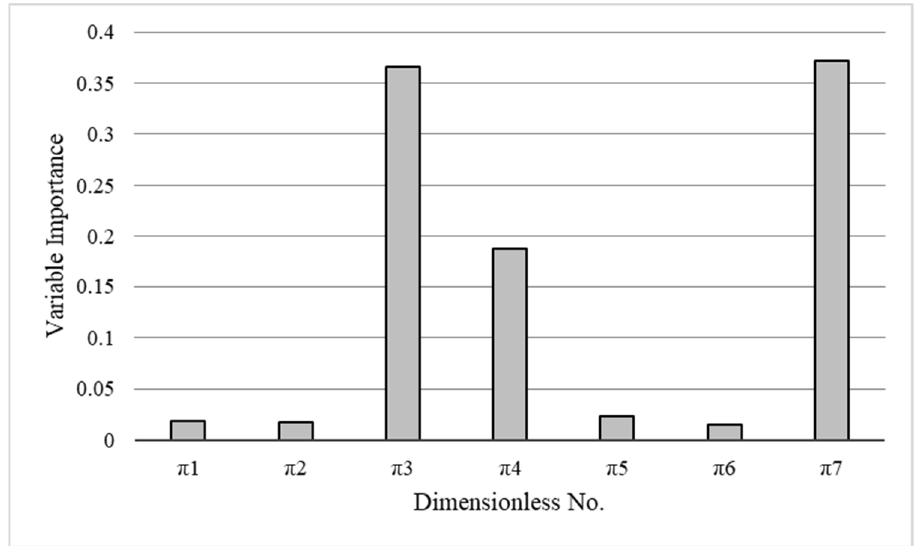
Figure 5. Relative importance of all input variables included in the new correlation for RF determi- nation of WAG injection